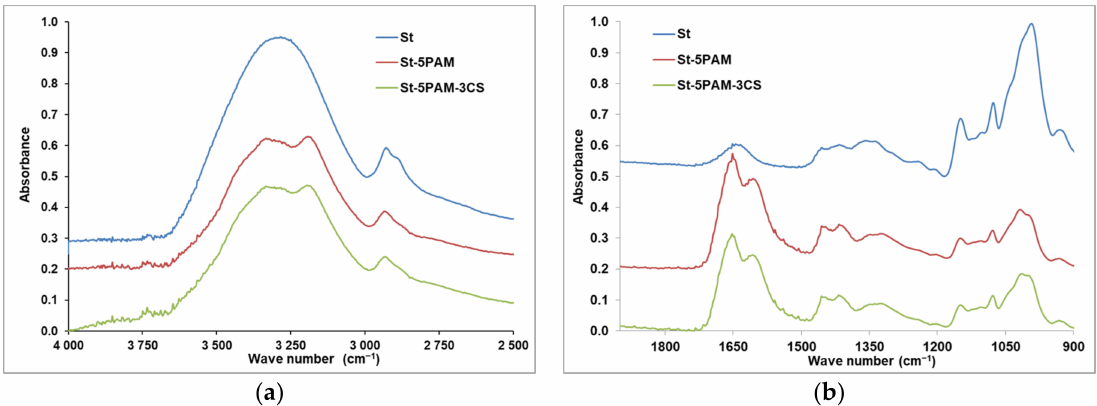
Figure 2. Fourier transform infrared (FTIR) spectra of native potato starch (St), starch grafted polyacrylamide copolymer with the St:AM molar ratio of 1:5 (St-5PAM) and starch grafted polyacrylamide hybrid with the St:AM molar ratio of 1:5 and 3 wt.% of CSs (St-5PAM-3CS) in characteristic wavenumber ranges: ( a ) 4000–2500 cm − 1 and ( b ) 1900–900 cm − 1